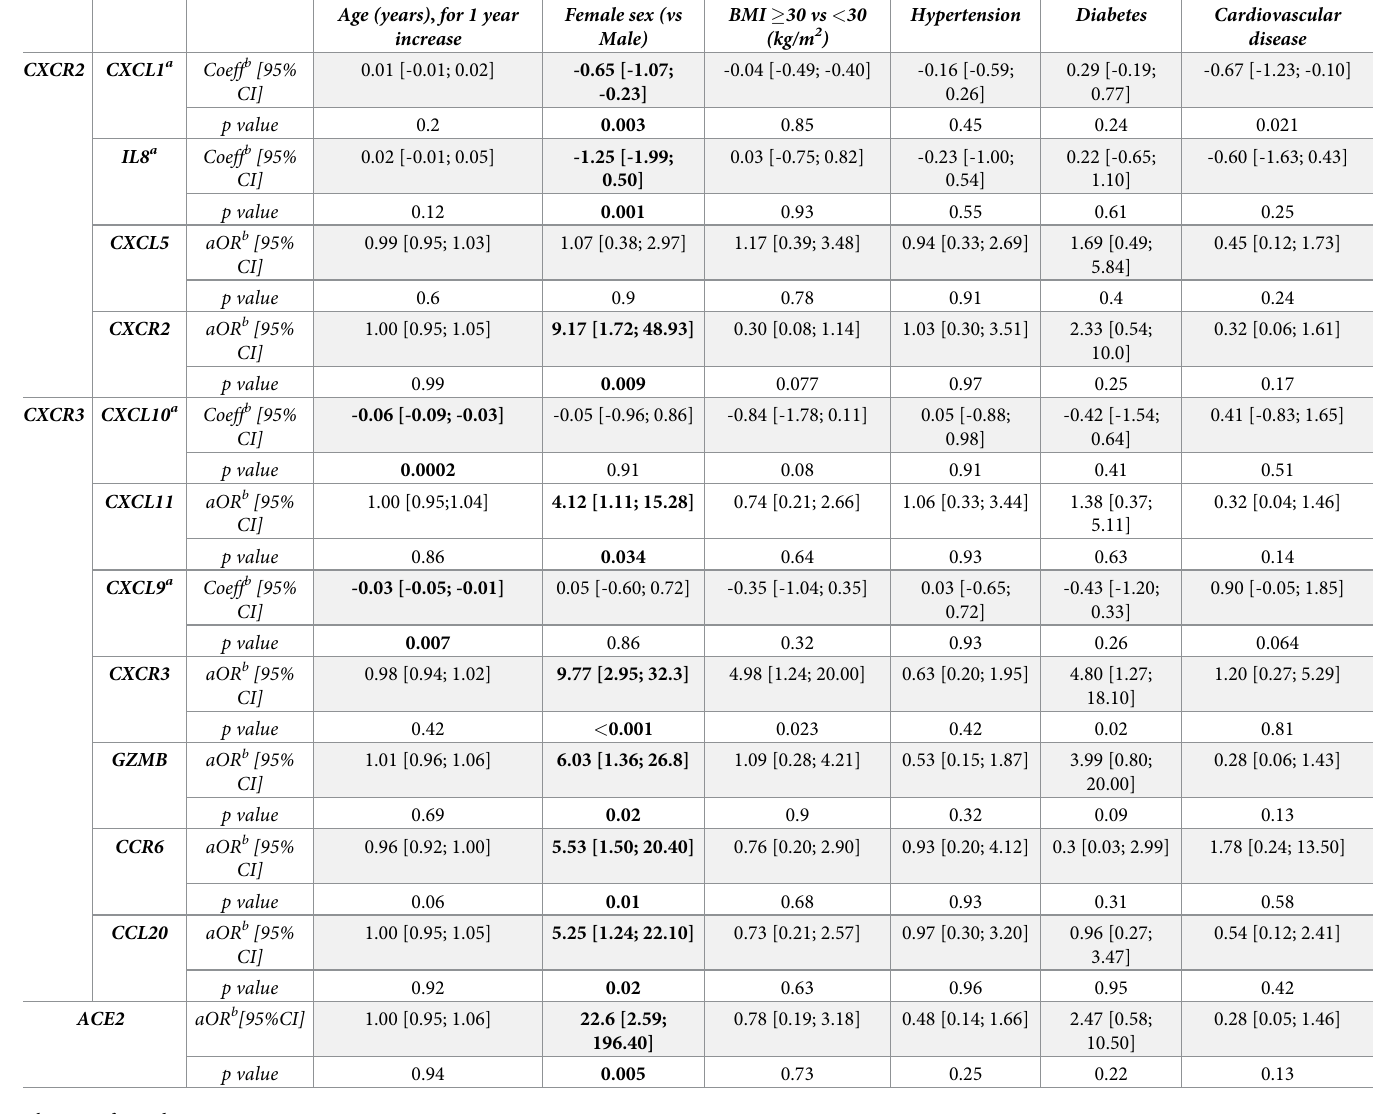
Table 3. Association between clinical factors and biomarker gene expression (n = 93). aOR indicate adjusted odds ratio. Significant associations (p < 0.05) are in bold.